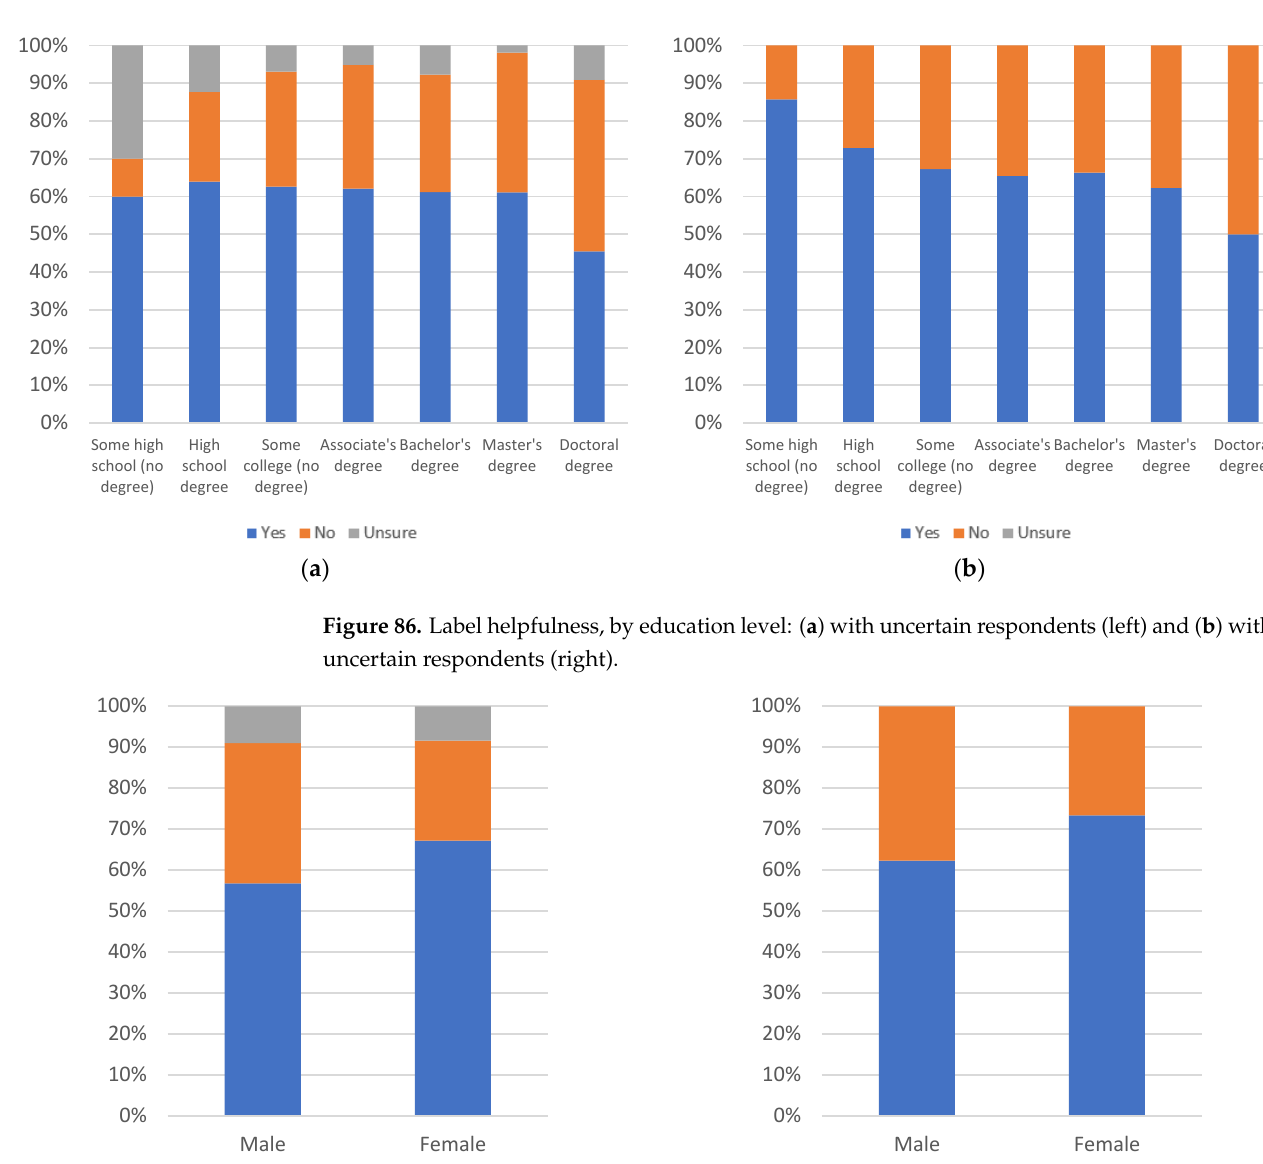
Figure 85. Label helpfulness, by age group: ( a ) with uncertain respondents (left) and ( b ) without uncertain respondents (right).